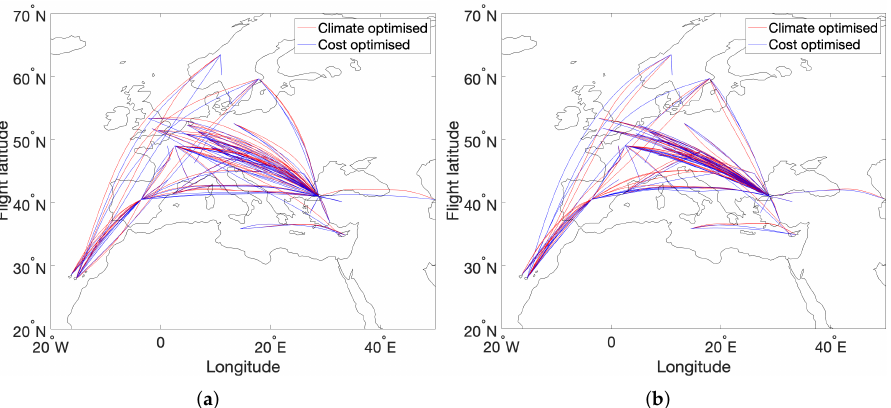
Figure 11. Horizontal profile of optimised routes with respect to costs (blue) and climate (red) with a fixed cruise altitude of FL340 ( ≈ 250 hPa) for ( a ) 1 February 2016 and ( b ) 1 August 2016. The flight altitude is fixed at 250